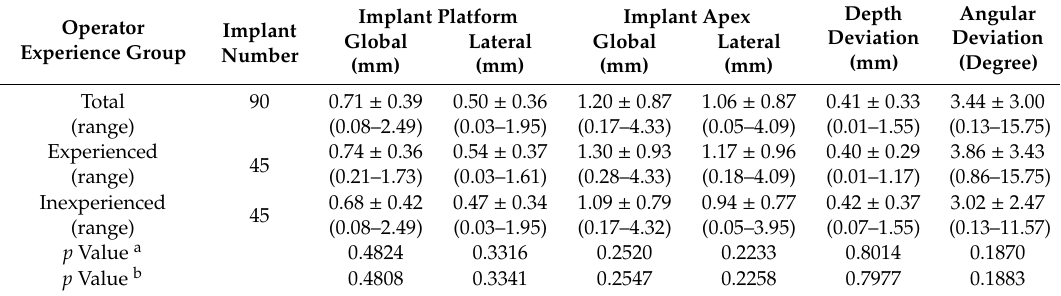
Table 2. Deviations between planned and placed implant position, by operator experience.